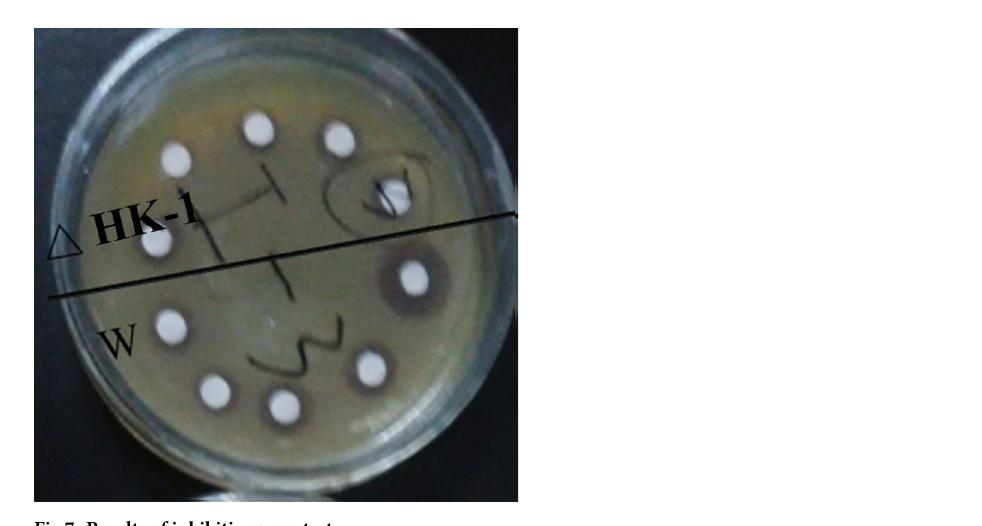
Fig 7. Results of inhibition zone test.